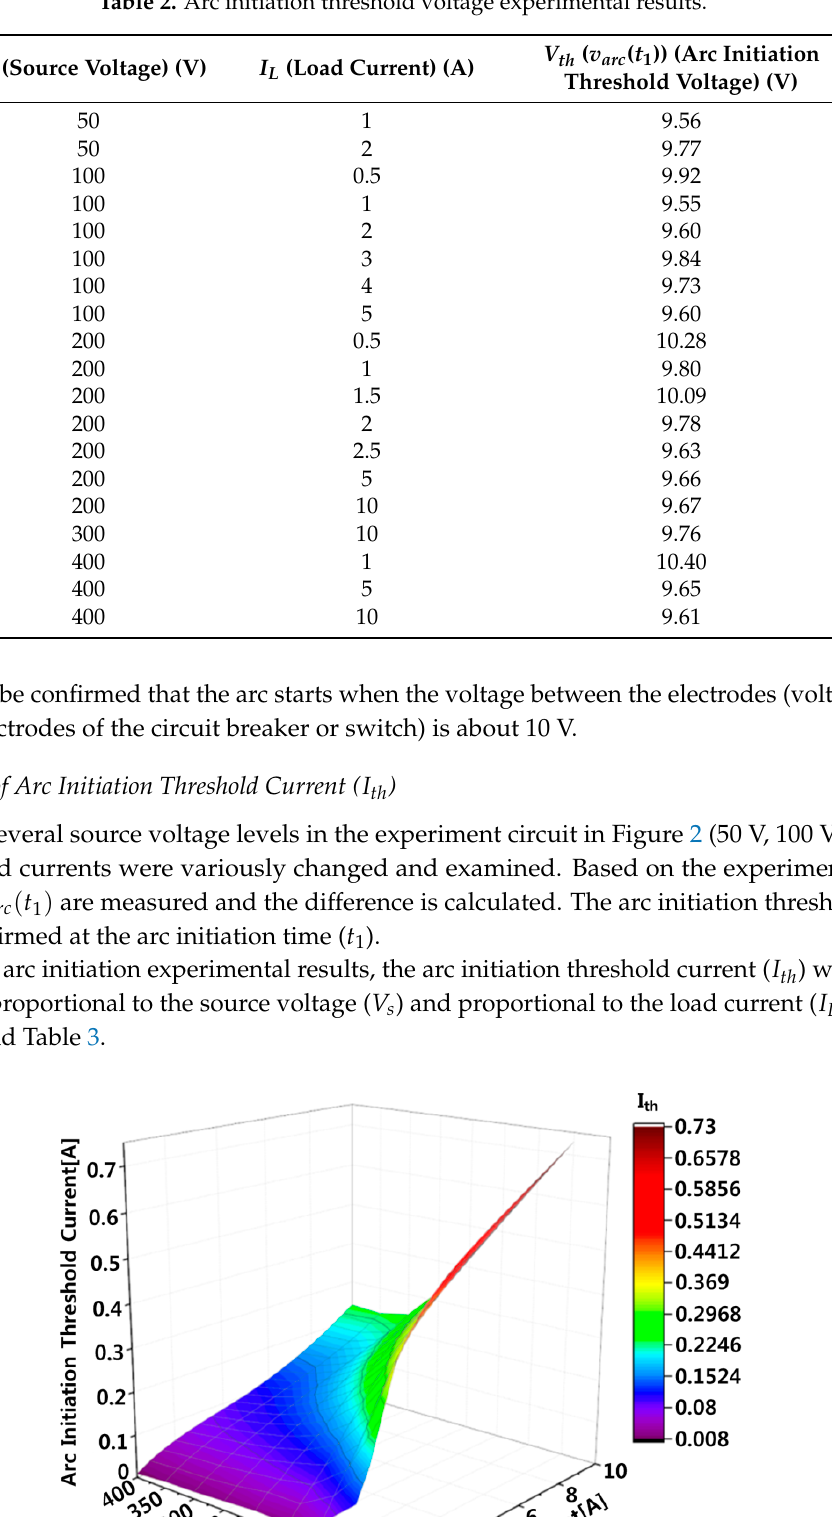
Table 2. Arc initiation threshold voltage experimental results.